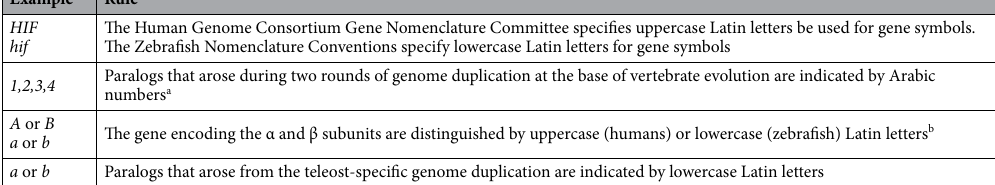
Table 1. Nomenclature conventions and synonyms for the hypoxia inducible factor. The gene symbols for hypoxia inducible factors generally have four parts, corresponding to the gene name, the vertebrate-specific paralog, whether it encodes an α or β subunit, and the teleost-specific paralog (for fishes). This study follows the conventions for humans because it has been broadly applied to other vertebrates and invertebrates 31 . a The hypoxia inducible factor 2 alpha subunit is also known as the endothelial PAS-domain protein, EPAS in humans and epas in zebrafish. b The hypoxia inducible factor β subunit is also known as the aryl hydrocarbon receptor nuclear translocator, ARNT in humans and arnt in